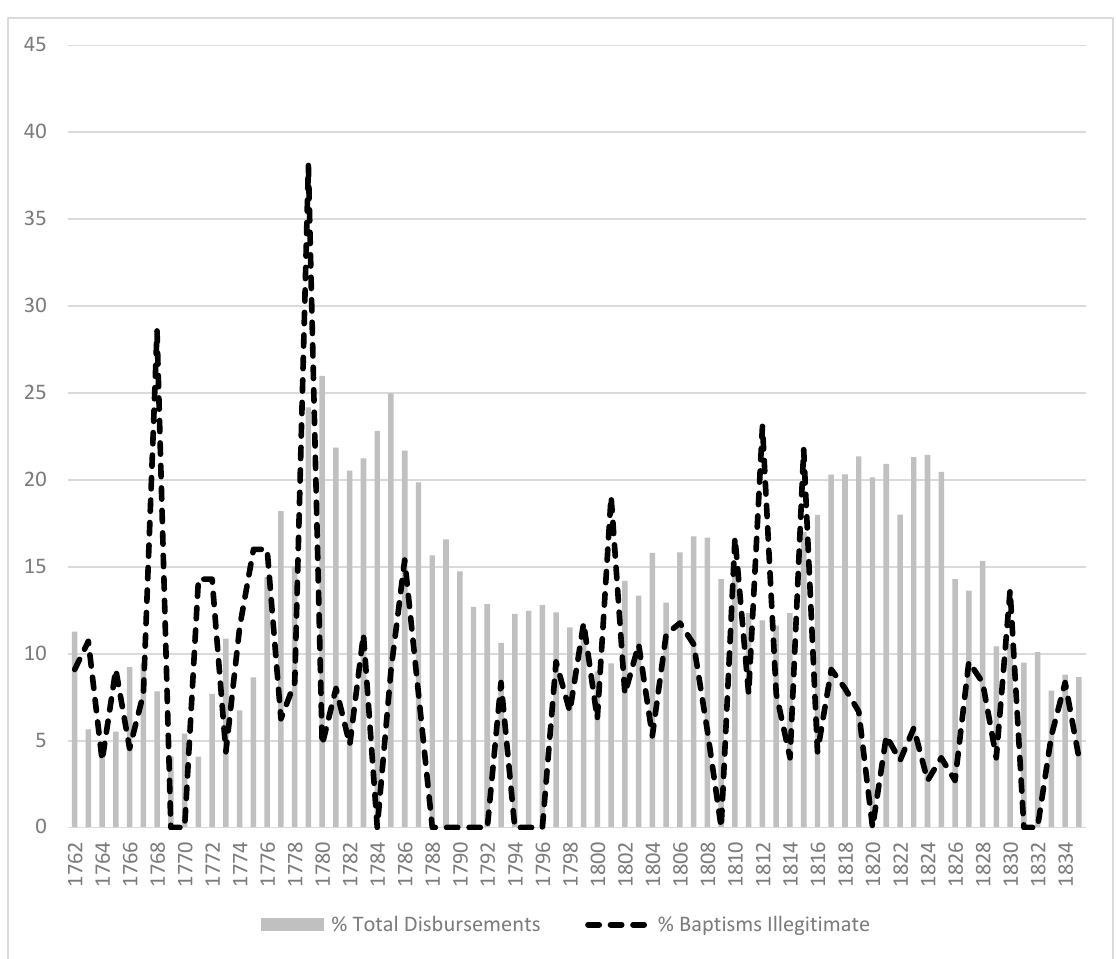
Figure 4. Butleigh, Somerset, 1762–1834: Percentage of Total Value of Annual Poor Relief Disbursements Paid to Illegitimate Children and their Mothers, Compared to Annual Percentage of Baptisms Recorded as Illegitimate.